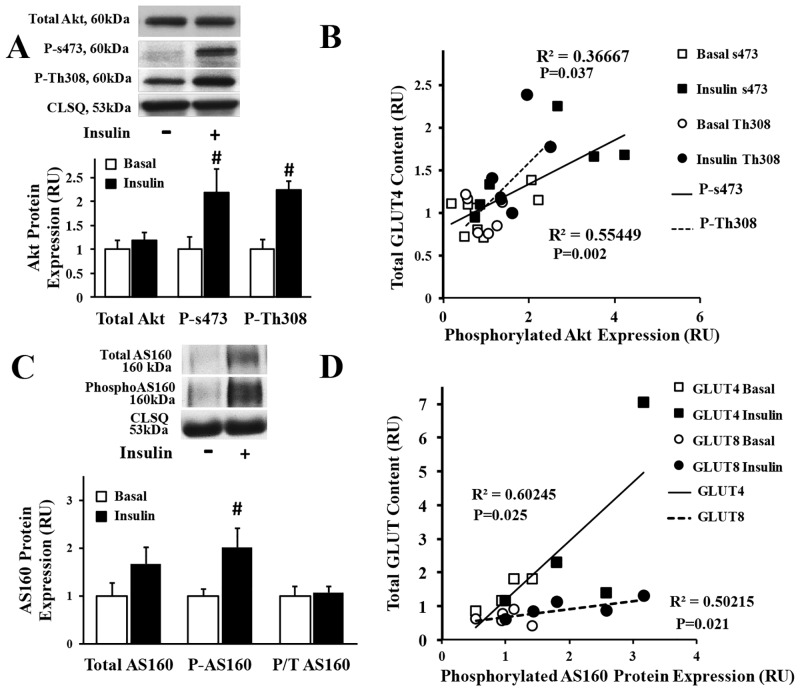
Analysis of the downstream insulin signaling pathways in the healthy atria.
A) Insulin stimulates phosphorylation of Akt at s473 and Th308 site in atrial myocytes. Top panel: representative Western blot from total lysate of isolated rat atrial myocytes incubated with (0.01μM) and without (basal) insulin; calsequestrin (CLSQ) was used as a loading control. Bottom panel: Mean ± SE of protein expression (values expressed relative to basal; n = 5/group); # P<0.05 vs. basal. B) Significant linear positive linear correlation between Akt phosphorylation (at s473 and Th308 site) and GLUT4 expression in the healthy atria. C) Insulin stimulates phosphorylation of AS160 in atrial myocytes. Top panel: representative Western blot from total lysate of isolated rat atrial myocytes; calsequestrin (CLSQ) was used as a loading control. Bottom panel: Mean ± SE of protein expression (values expressed relative to basal; n = 6-8/group); # P<0.05 vs. basal. D) Significant linear correlation between AS160 phosphorylation and GLUT-4 and -8 expression in the healthy atria.